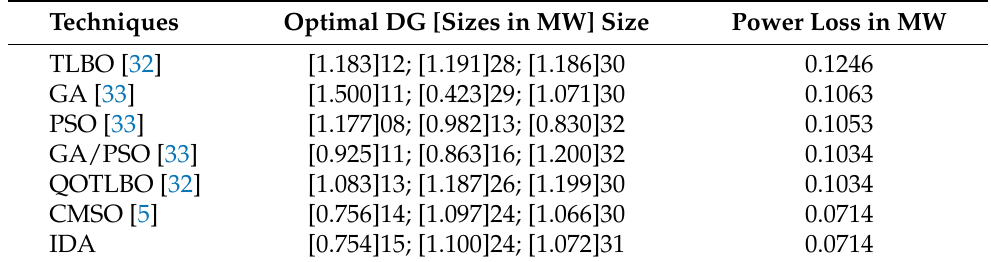
Table 3. Simulations results of single objective optimization problem for power loss minimization.